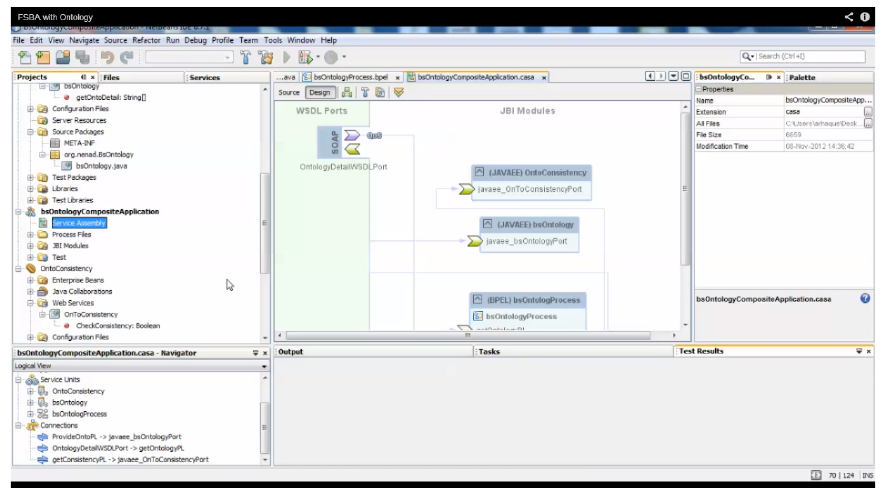
Figure 7. Graphical View of of Financial Service